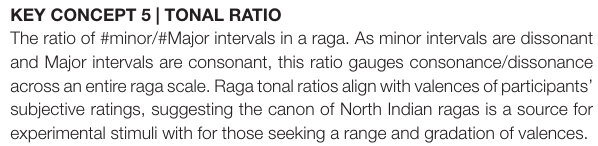
is indicated along with the name of the respective thaat . Figure